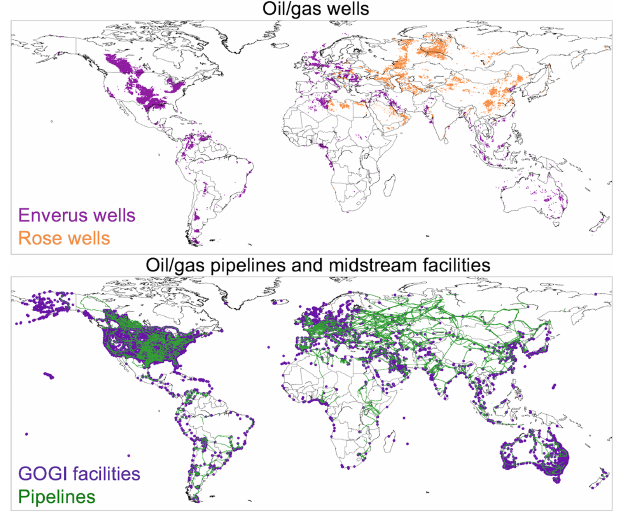
Figure 2. Global distributions of oil and gas wells (Enverus, 2017; Rose, 2017), pipelines (EIA, 2018b; Petroleum Economist Ltd, 2010; Sheng et al., 2017; Sabbatino et al., 2017), and midstream facilities (Sabbatino et al., 2017) used in our inventory. Well loca- tions for individual countries are from the Enverus (2017) database where available and from the Rose (2017) database everywhere else (see text). Wells and pipelines are gridded data at 0 . 1 ◦ × 0 . 1 ◦ grid resolution but are shown here with 0 . 2 ◦ × 0 . 2 ◦ resolution for visi-